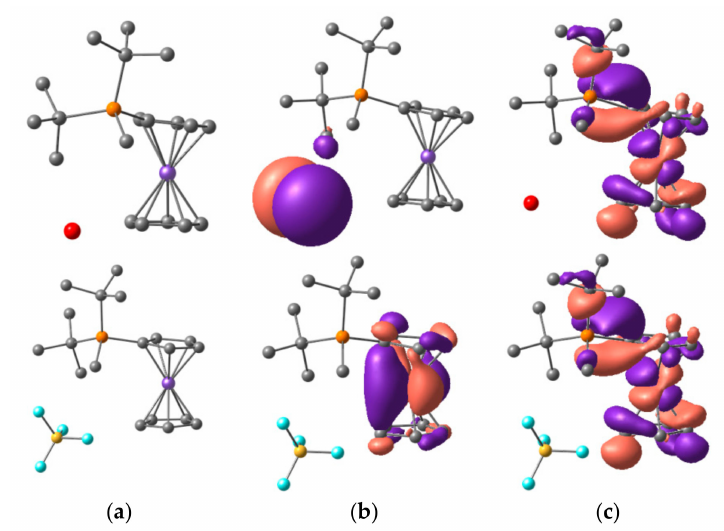
Figure 7. Structures of considered ion pairs of m1 ( a ) with Br − ( top ) and [BF 4 ] − ( bottom ) anions and corresponding HOMO ( b ) and LUMO ( c